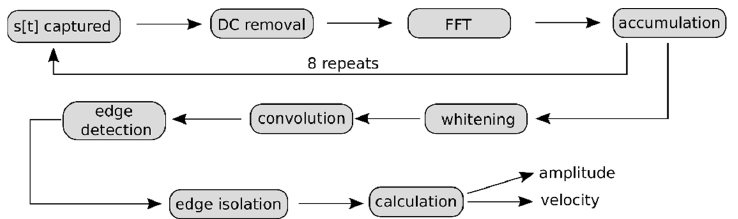
Figure 6. Digital signal processing flowchart. Each step is displayed in the grey boxes. Example data for the processed signal after certain steps can be found in Figure 7. The algorithm begins at s [ t ] captured.